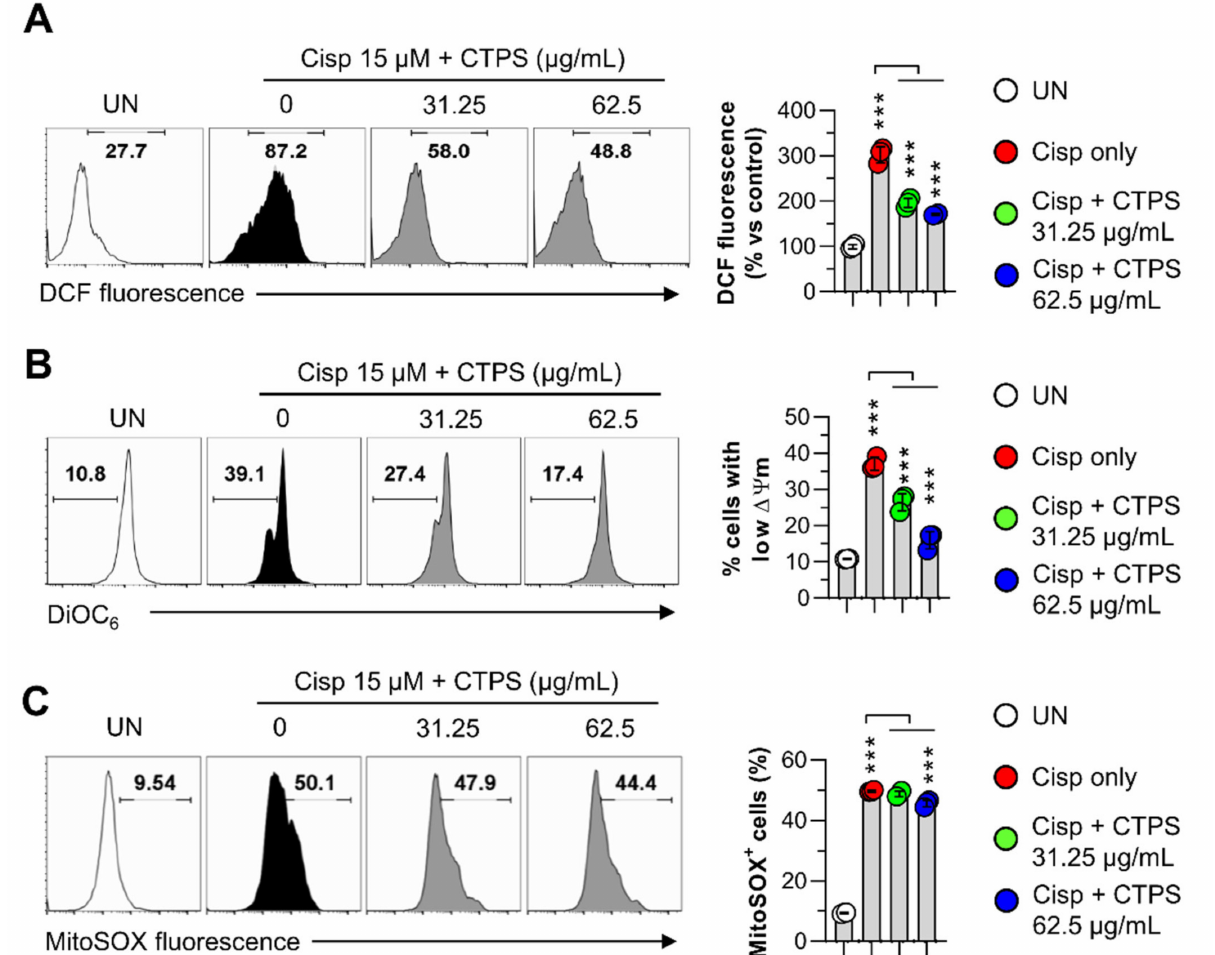
Figure 4. CTPS reduces the ROS production and loss of mitochondrial transmembrane potential in cisplatin-treated macrophages. Following pretreatment with CTPS (31.25 and 62.5 µ g/mL) for 2 h, non- or CTPS-treated RAW264.7 cells were treated with 15 µ M cisplatin for 24 h followed by H 2 DCFDA measurement ( A ), DiOC 6 staining ( B ), or MitoSOX staining ( C ). The cells were analyzed via flow cytometry using FACSVerse TM flow cytometer. The histograms are representative data of three independent experiments. The data are expressed as the mean ± standard deviation ( n = 3). *** p < 0.001. UN: untreated cells; CTPS, Cudrania tricuspidata -derived polysaccharides; cisp, cisplatin; H 2 DCFDA, 2 (cid:48) ,7 (cid:48) -dichlorodihydrofluorescein diacetate; DiOC 6 , 3,3 (cid:48) -dihexyloxacarbocyanine iodide; TUNEL, terminal deoxynucleotidyl transferase dUTP nick end labeling; FITC, fluorescein